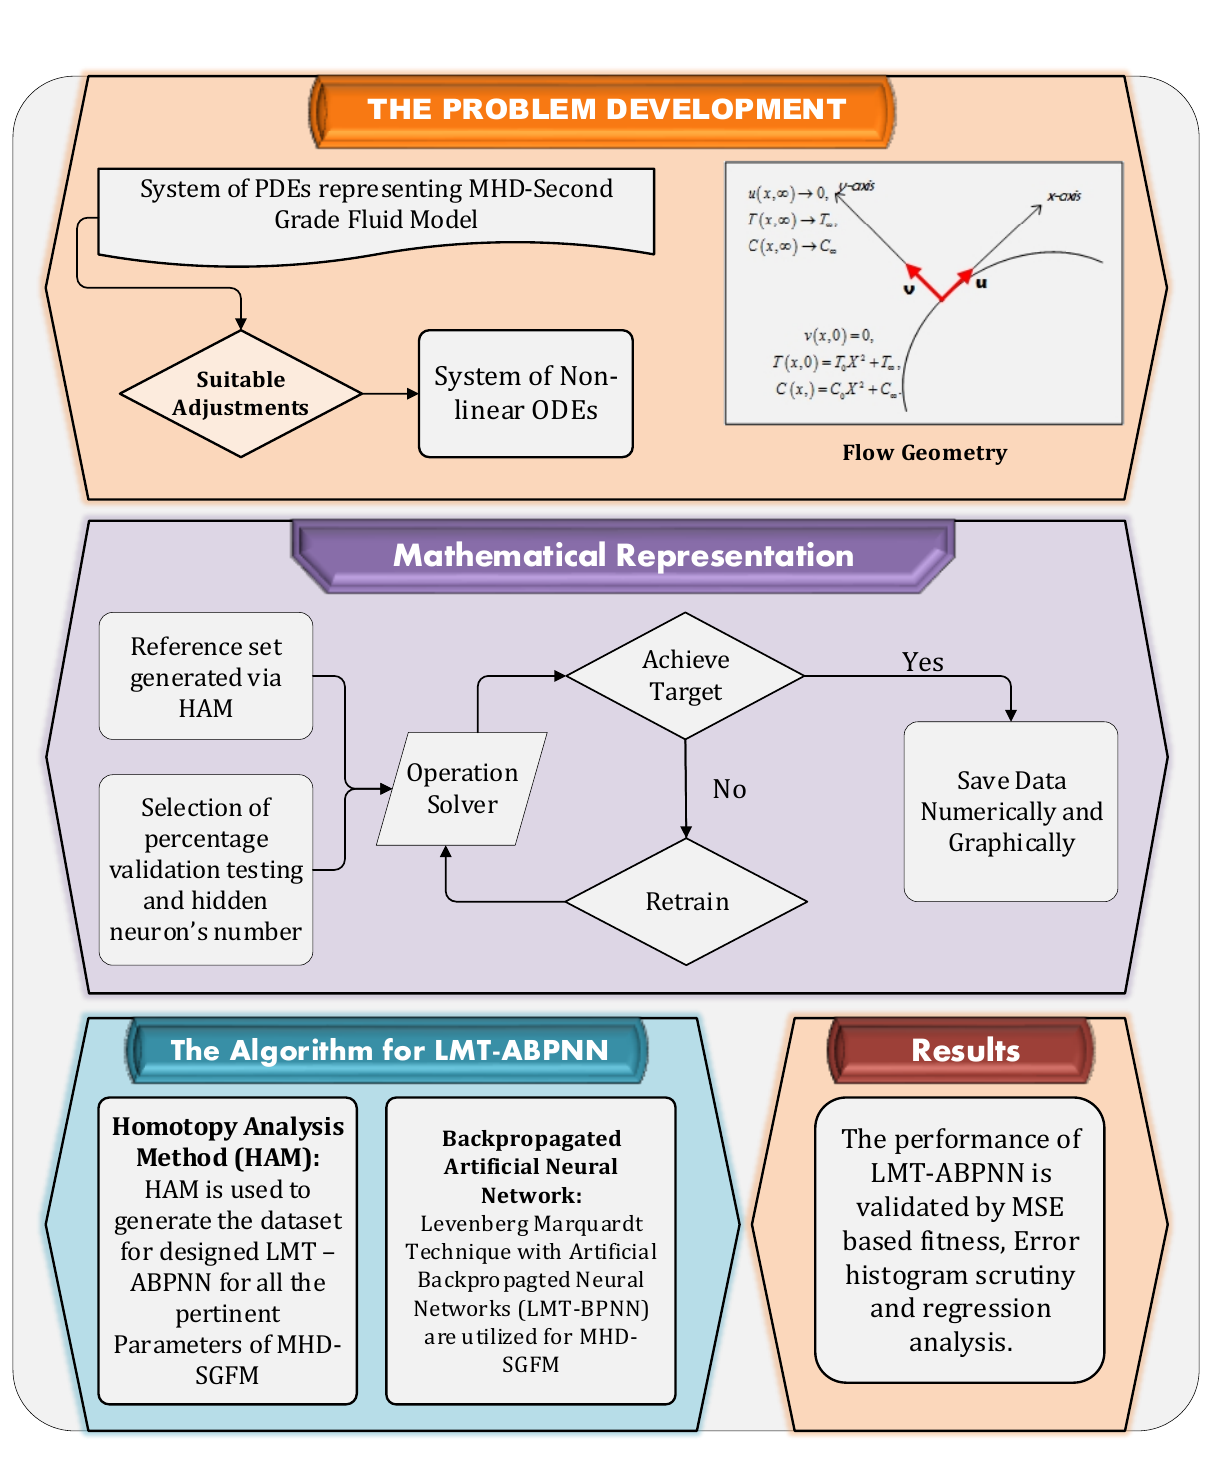
Figure 3. The Flow Architecture for MHD-SGFM.